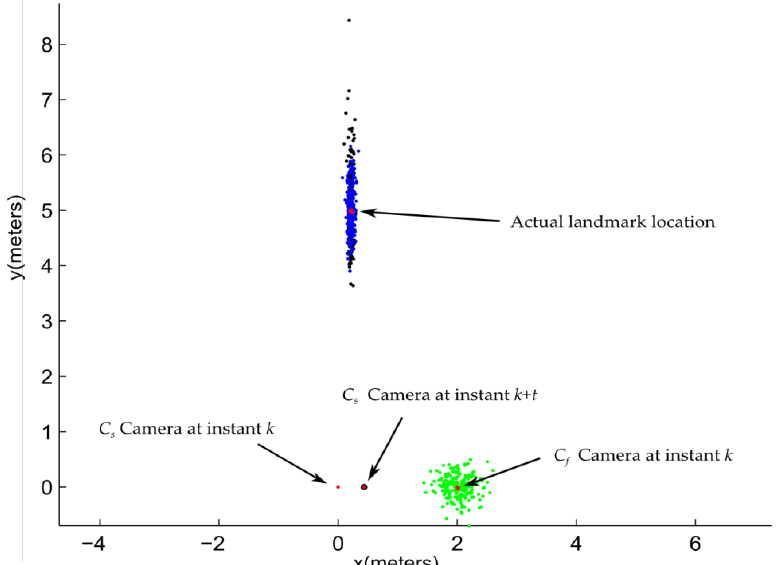
Figure 10. Initialization of a single landmark using: (i) the ID-delayed monocular method; and (ii) the pseudo-calibrated stereo rig approach. The actual position of the cameras and the landmark are indicated by red dots. Estimated locations of the landmark obtained by the ID-delayed method are indicated by the cloud of black points. Estimated locations of the landmark obtained with the pseudo-calibrated stereo rig are indicated by the cloud of blue points. Every green point indicates an observation of the C f